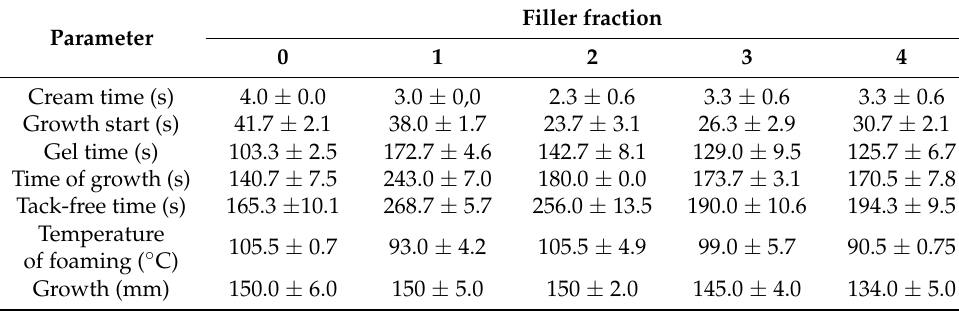
Table 3. The time characterizing the foaming